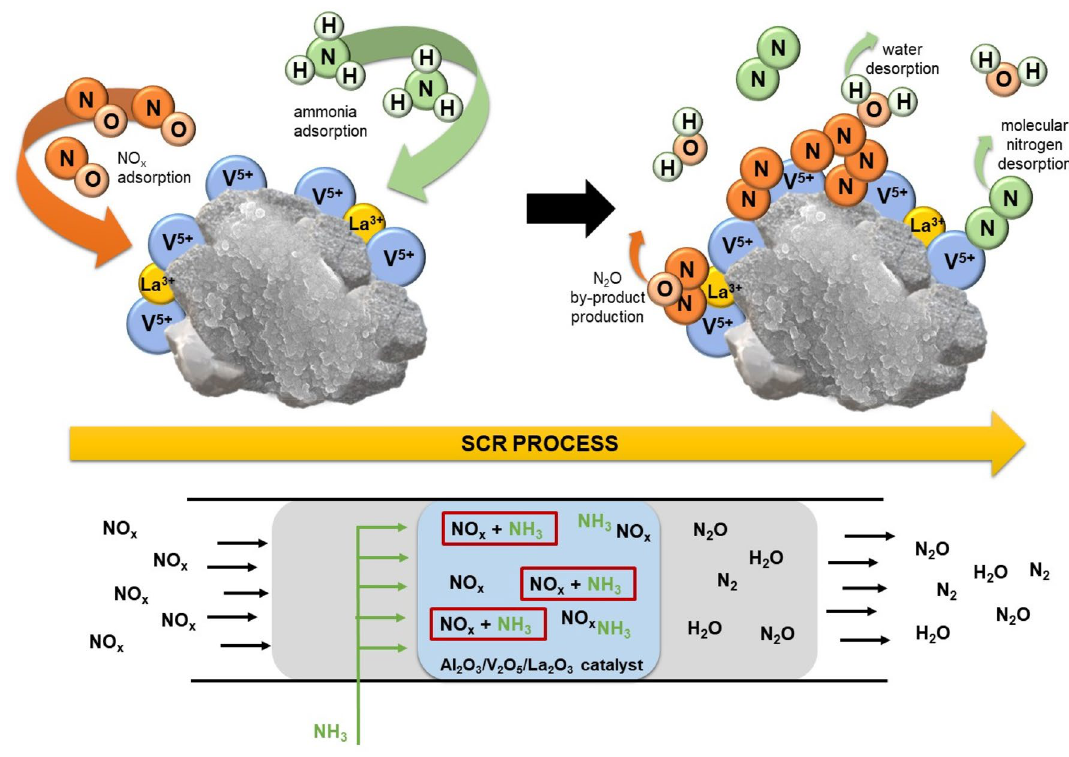
Figure 6. Proposed mechanism of selective catalytic reduction of NO x induced with ammonia on Al 2 O 3 /V 2 O 5 / La 2 O 3